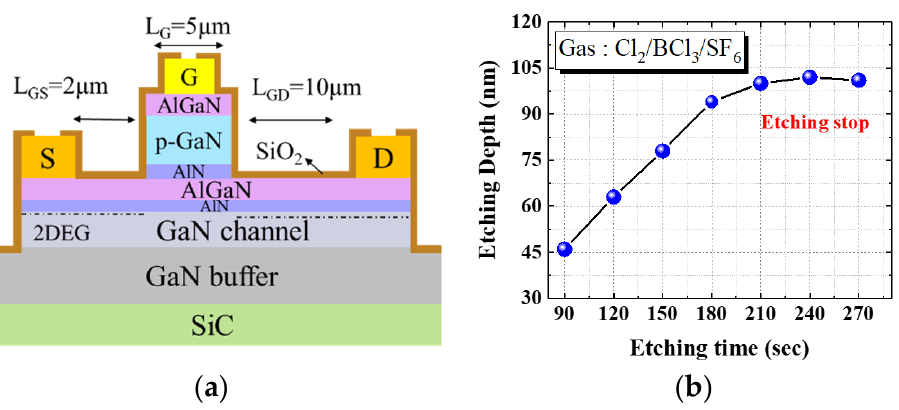
Figure 1. ( a ) Cross-sectional schematic of the p-GaN gate HEMT, and ( b ) the etching stop technique. Finally, an Al 0.2 Ga 0.8 N layer of 10 nm thickness was grown on the p-GaN layer. In the device fabrication, the p-GaN etching of Cl 2 /BCl 3 /SF 6 was achieved using inductively coupled plasma, and the AlN layer acted as an etching stop layer. The etching stop technique employed was similar to that used in the p-GaN etching process [13–15]. The etching rate for p-GaN layer etching was approximately 31.5 nm/min. From 210 to 270 s, the etching rate was reduced to less than 2 nm/min because of generation of the AlF 3 layer (etching stop layer). This etching stop technique prevents overetching in the p-GaN removal process, as shown in Figure 1b. Ohmic contacts were prepared through electron beam evaporation, and Ti, Al, Ni, and Au layers (thickness = 25, 120, 25, and 150 nm, respectively) were stacked on the device sequentially. Both devices were then annealed using a rapid thermal annealing system at 875 ◦ C for 30 s in ambient N 2 . Finally, a Ni/Au (25/120 nm) gate metal stack was deposited and a 100-nm SiO 2 passivation layer was